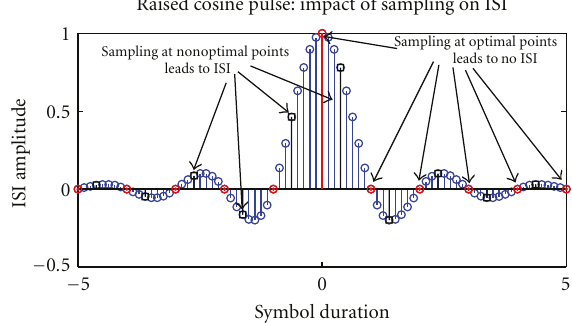
Figure 5: Raised cosine pulse: impact of sampling on